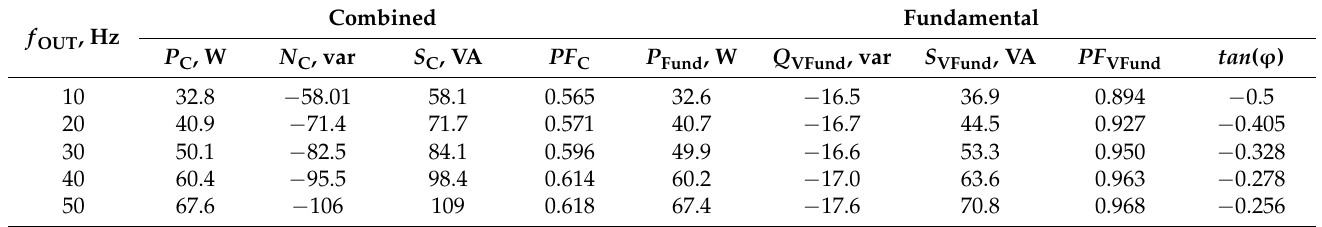
Table 2. Power components at the point of connection of Rockwell Automation Power Flex 70